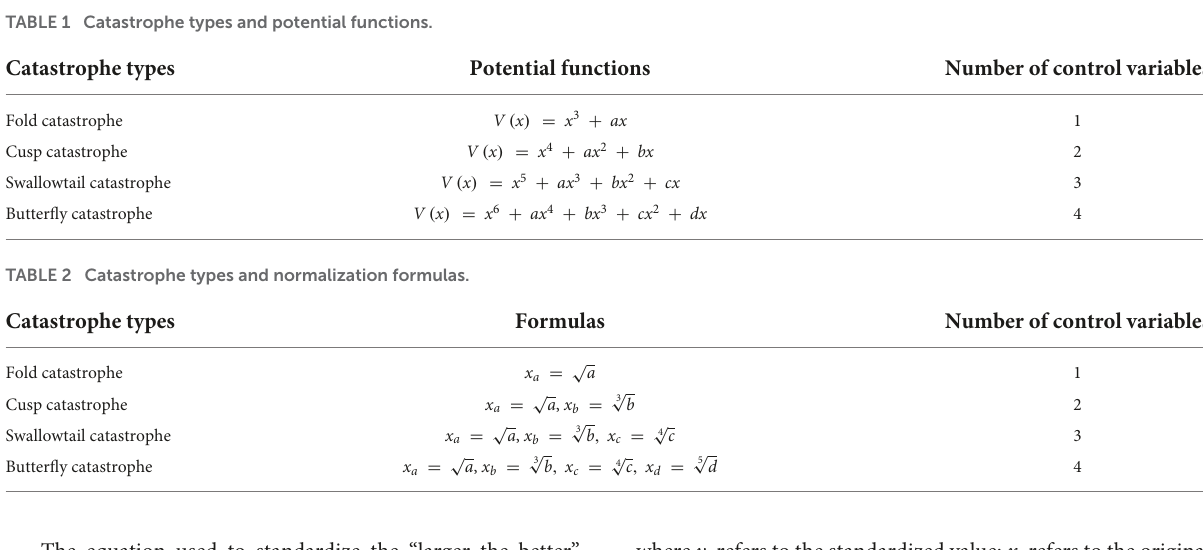
TABLE 1 Catastrophe types and potential functions.